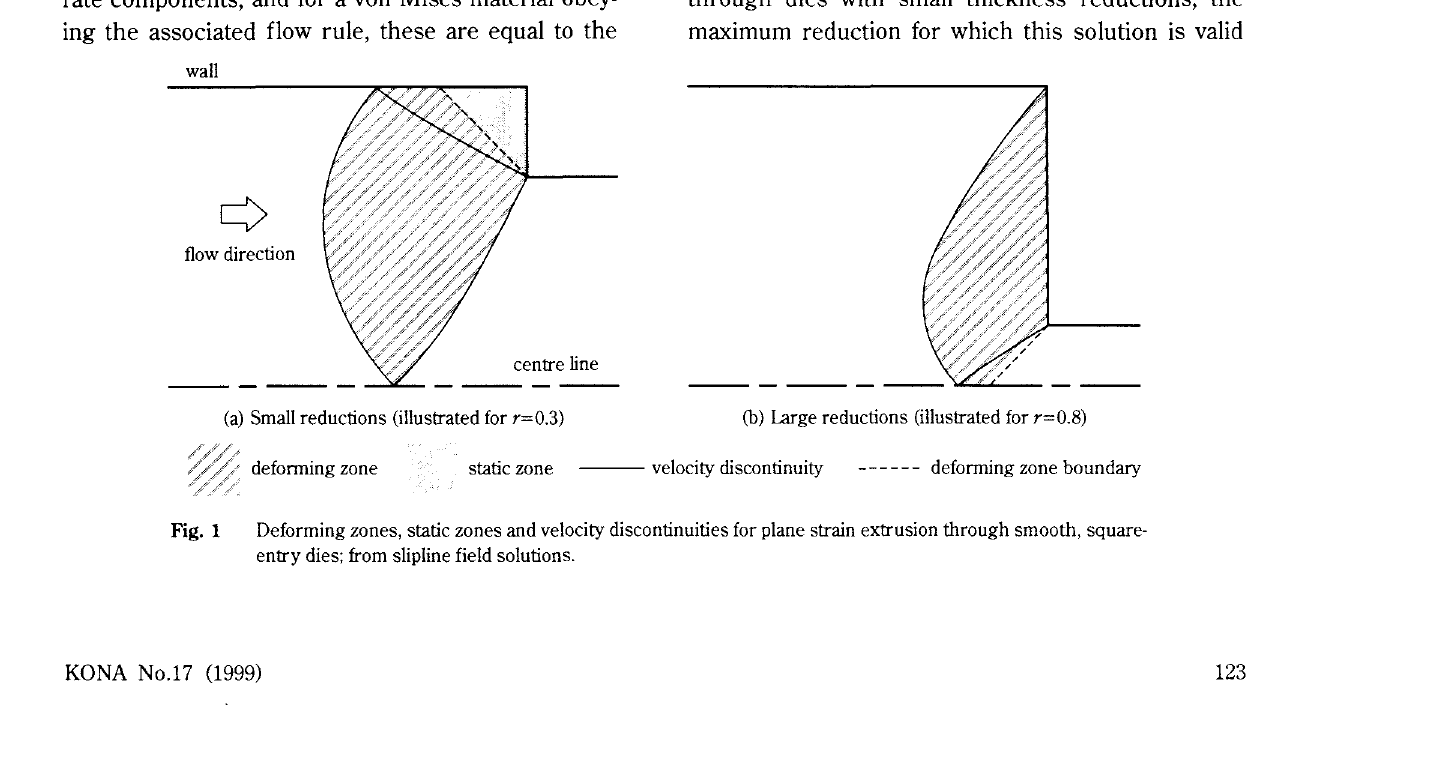
Fig. 1 Deforming zones, static zones and velocity discontinuities for plane strain extrusion through smooth, square entry dies; from slipline field